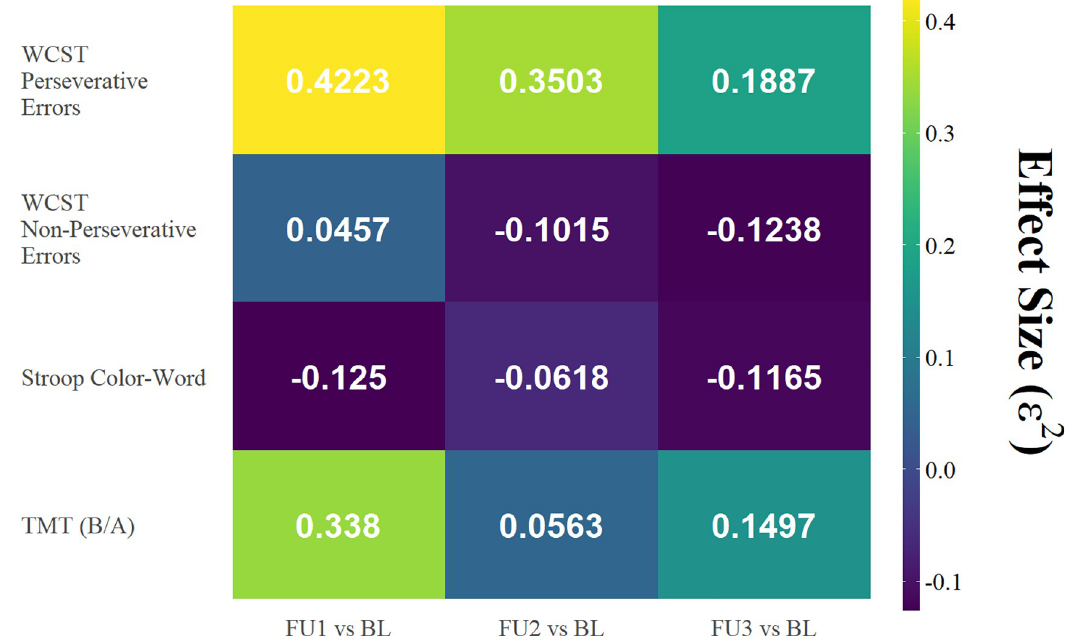
Fig 3. Effect size (epsilon-squared). Separate mixed-design ANOVAs were performed in order to estimate the effect size for the time x condition interaction term at each level of comparison for each neuropsychology test score of interest.